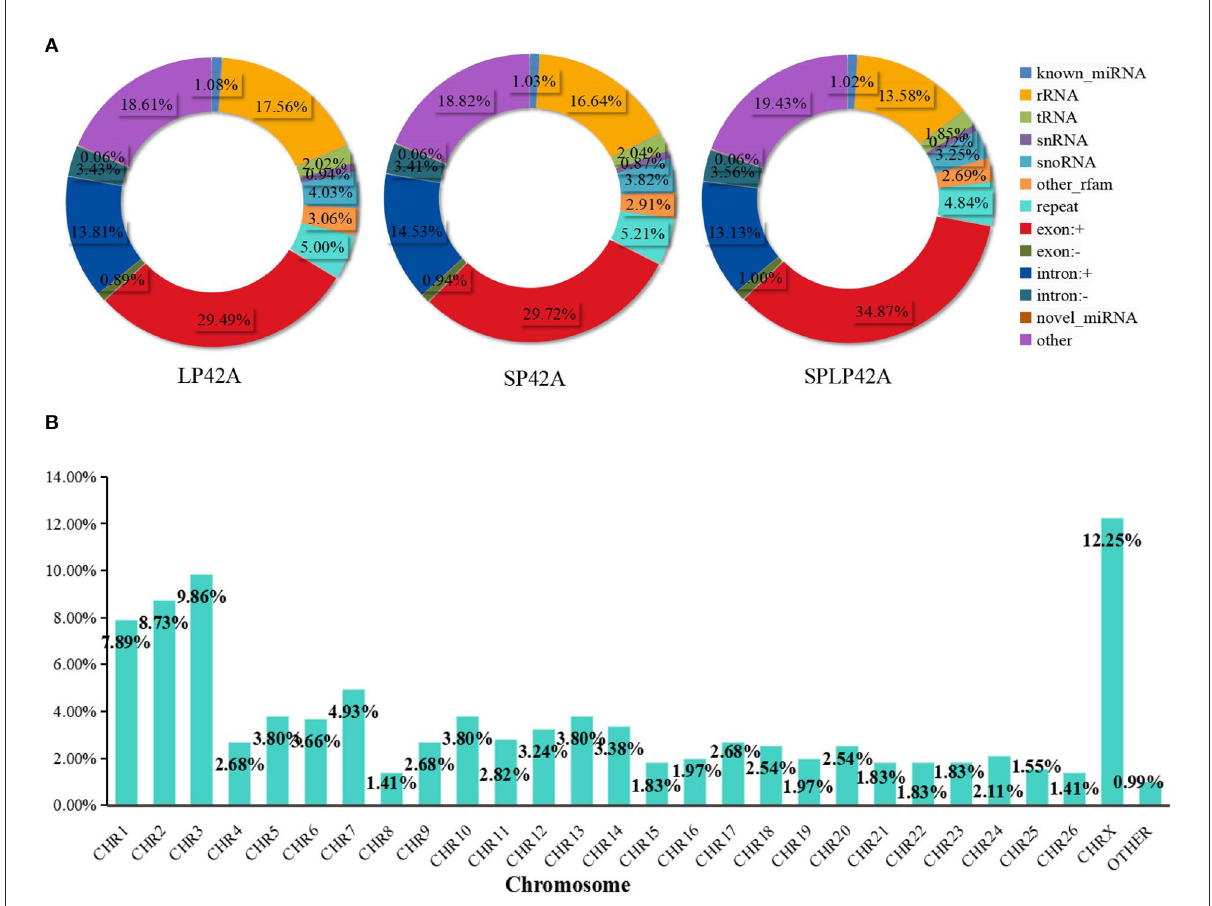
FIGURE2 Summary information of sRNA identification. (A) The statistical results of unique clean reads from the adrenal gland in the three experimental groups. (B) Chromosome distribution of identified miRNA from the adrenal gland.